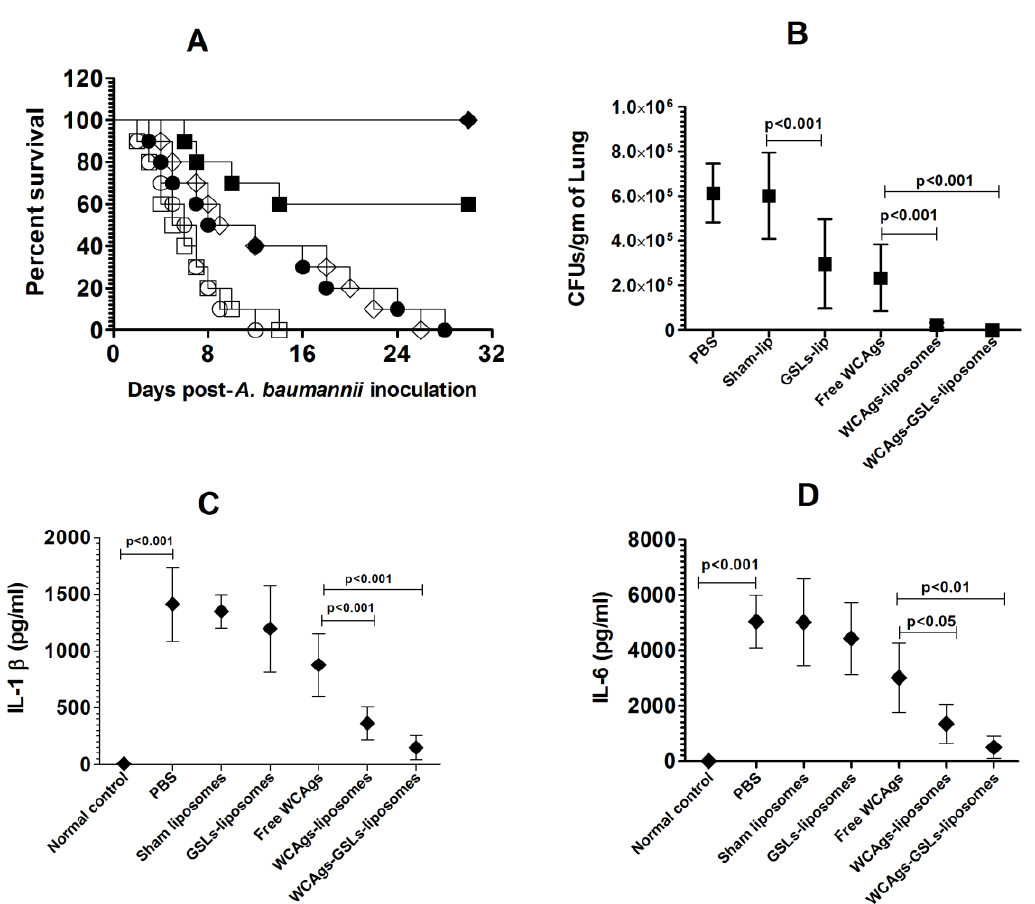
Figure 7. Vaccination with WCAgs-GSLs-liposomes effectively protected mice against A. baumannii . ( A ) Each control or immunized mouse was infected with 5 × 10 6 bacterial cells and monitored daily for 30 days. PBS (  ), Sham-lip (  ), GSLs-lip (  ), free WCAgs (  ), WCAgs-liposomes (  ), WCAgs- GSLs-liposomes ( ◆ ). WCAgs-GSLs-liposomes vs. WCAgs-liposomes ( p = 0.0291), WCAgs-GSLs- GSLs‑liposomes ( ♦ ). WCAgs‑GSLs‑liposomes vs. WCAgs‑liposomes ( p = 0.0291), liposomes vs. free WCAgs ( p < 0.001), WCAgs-liposomes vs. free WCAgs ( p = 0.0102). ( B ) The bac- terial load was analyzed in the lung tissues, as described in the methodology. ( C ) IL- 1β and ( D ) IL- 6 levels in BAL fluid of the control and immunized mice. The values are expressed as the means ± SD.